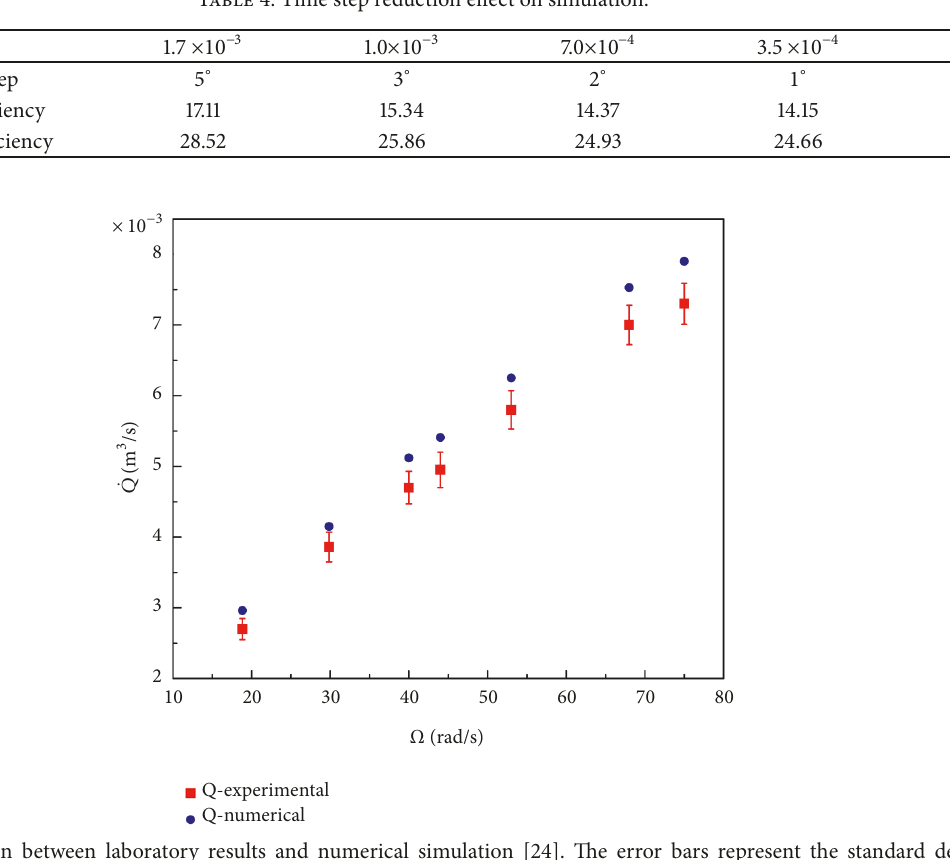
Figure 7: Comparison between laboratory results and numerical simulation [24]. The error bars represent the standard deviation of measurements for 5 repetitions of every operating